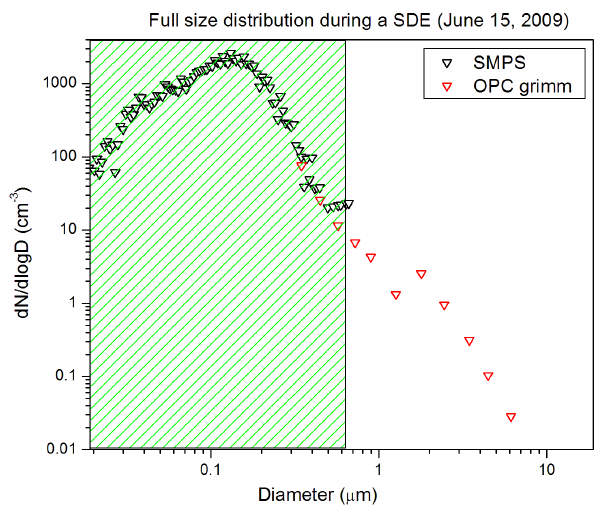
Fig. 8. Full size distribution during a Saharan Dust Event on 15 June 2009. The green shaded area corresponds to the fraction of particles sampled through PINC within a SDE.